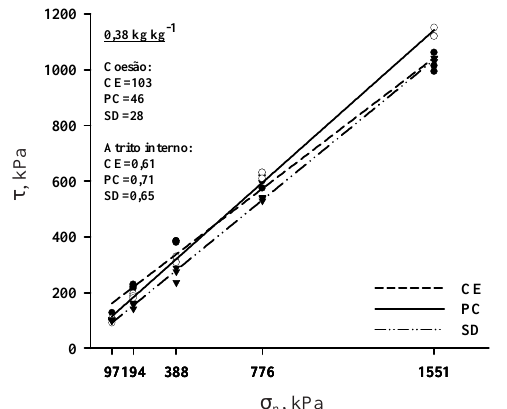
Figura 9. Relação linear simples entre a tensão normal ( σσσσσ ) e tensão cisalhante ( τττττ ) do Latossolo n Vermelho distrófico, sob cerradão (CE), preparo convencional (PC) e semeadura direta (SD), com seus respectivos parâmetros de intercepto de coesão e coeficiente de atrito, para a umidade de 0,38 kg kg -1